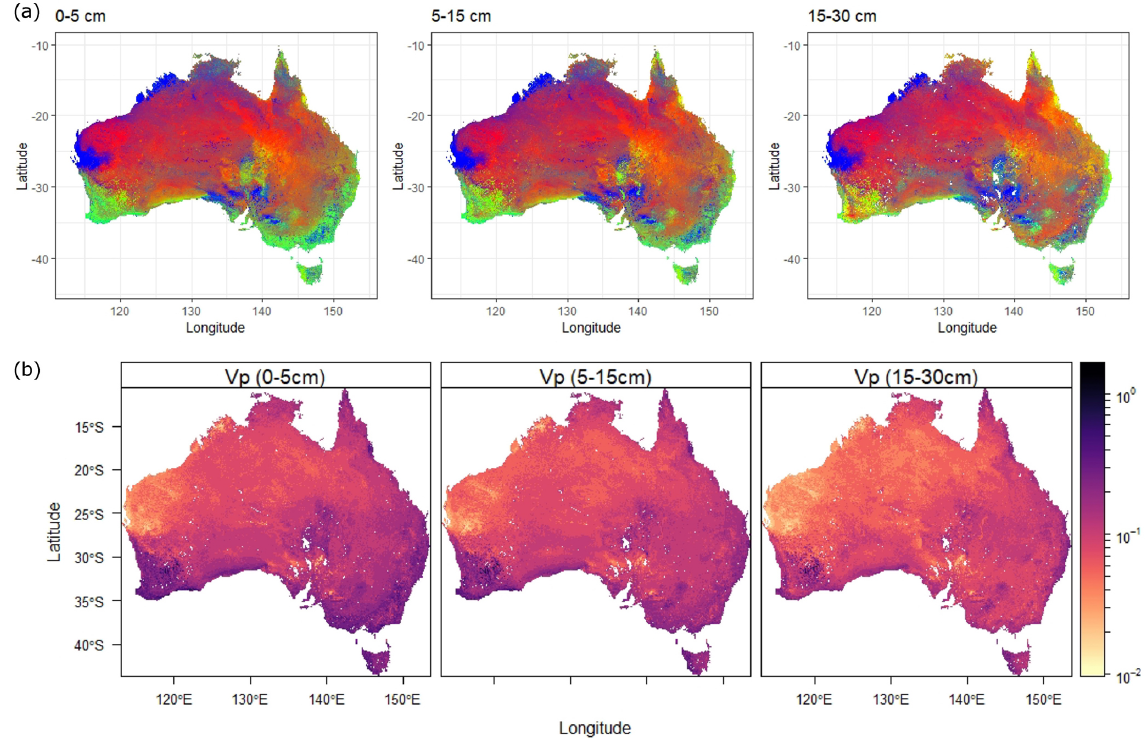
Figure 7. (a) Composite of the contributions of the three SOC fractions to SOC for the depth intervals 0–5, 5–15, and 15–30cm. The colours indicate the dominant fractions with MAOC in red, POC in green, and PyOC in blue. (b) SOC vulnerability for the three depth intervals. SOC vulnerability is in the log10 scale for better